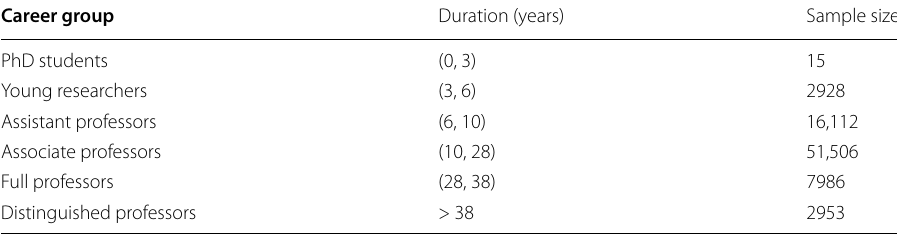
Table 4 Career groups and corresponding sample size (number of researchers in our dataset) Career